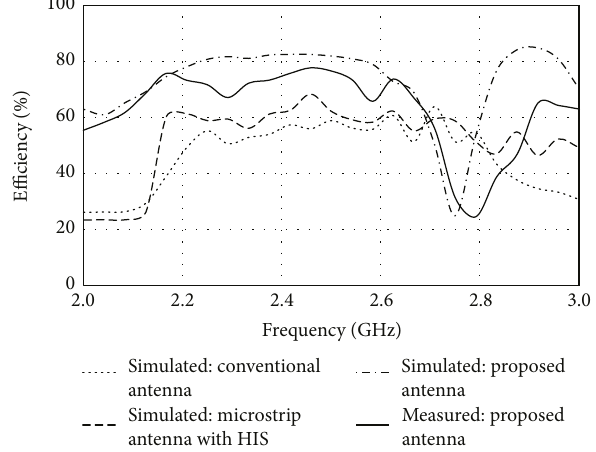
Figure 16: The simulated and measured antenna gains under various antenna schemes.